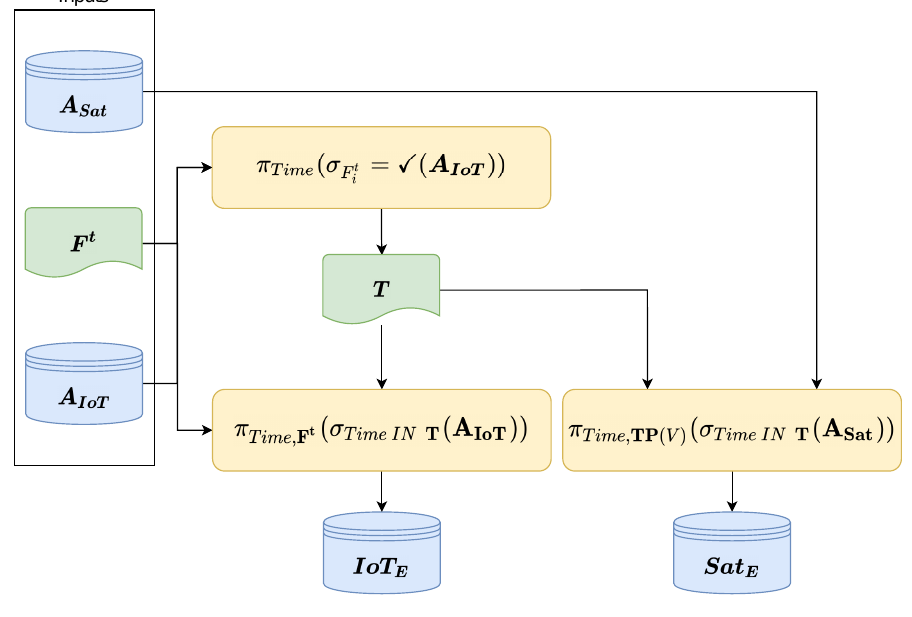
Figure 3. Data selection